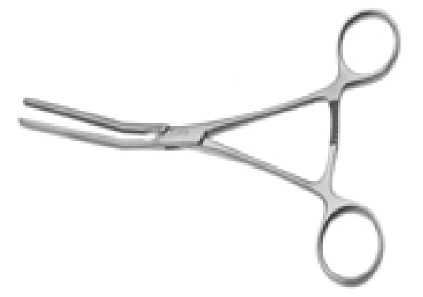
Figure 1: Atraumatic DeBakey vascular clamp.